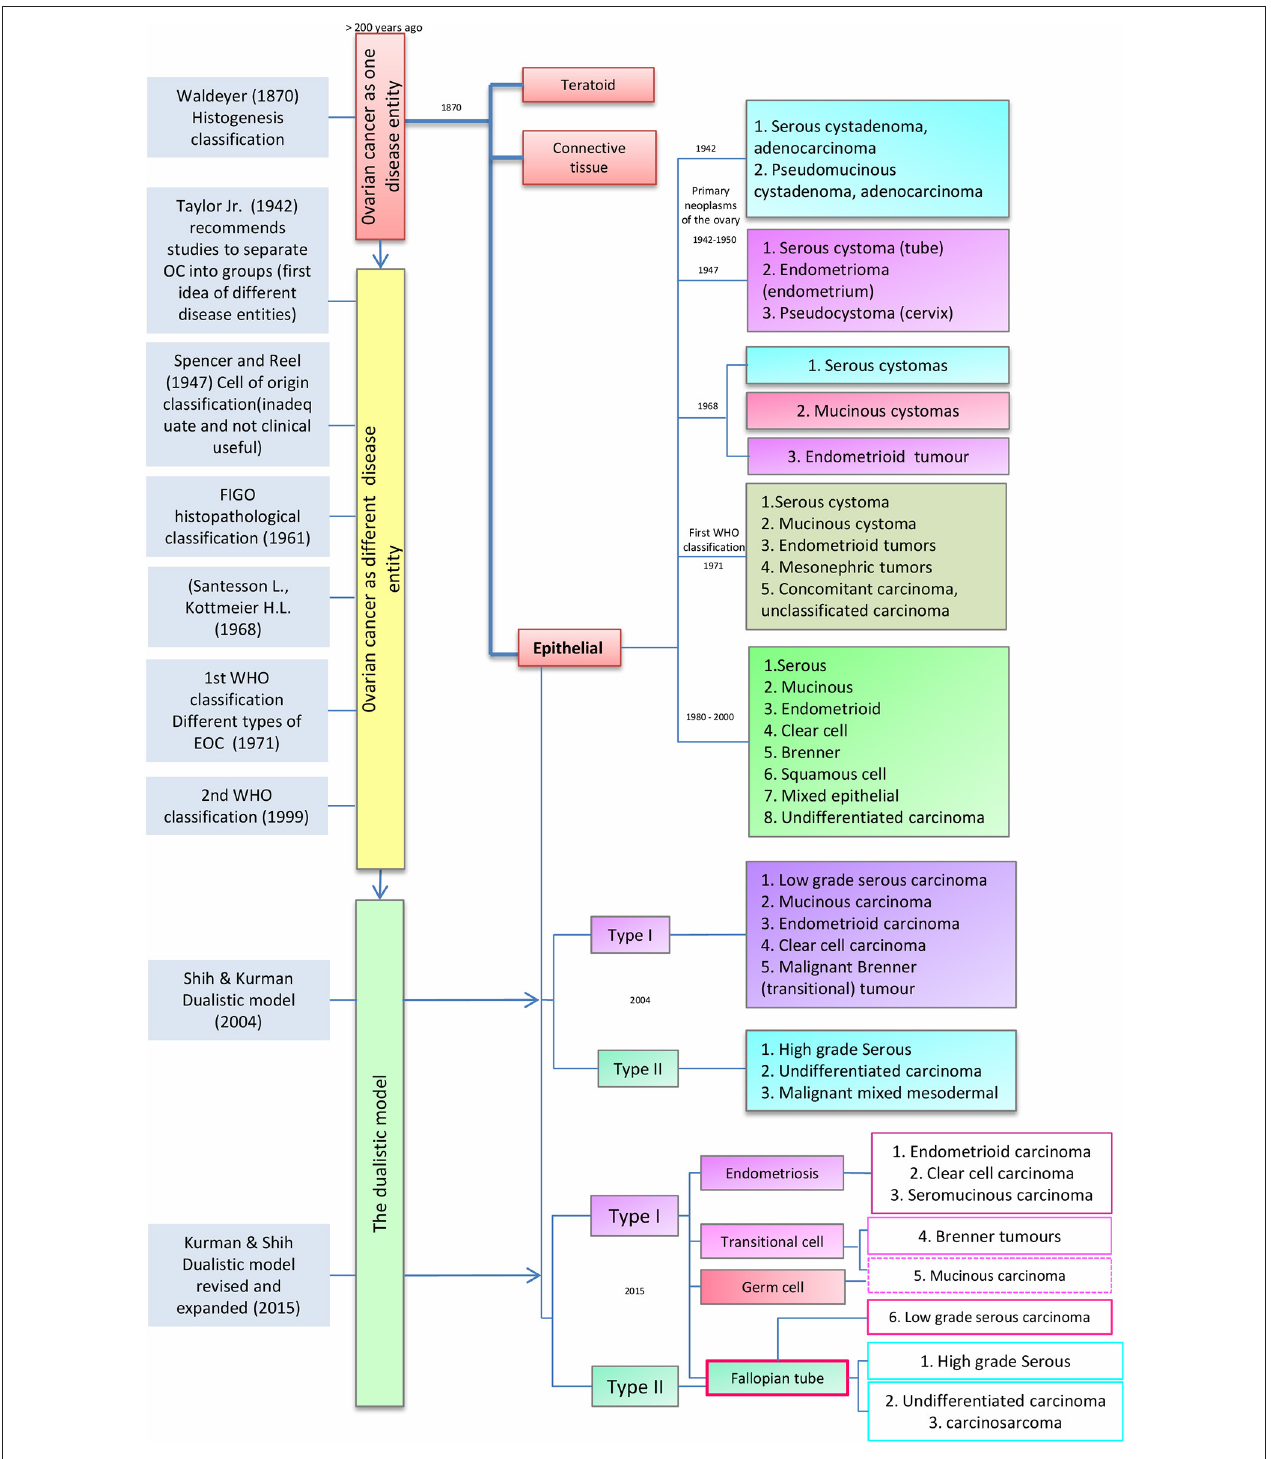
FIGURE 1 | Timeline classification of epithelial ovarian cancer. Blue boxes on the left show author contributions to ovarian cancer (OC) classification over time. Red, yellow, and green boxes represent the evolution of OC classification from a single disease entity to a binary model. Finally, the different sub classifications of epithelial ovarian cancer (center red box), are presented from 1942 to the latest model in 2015.